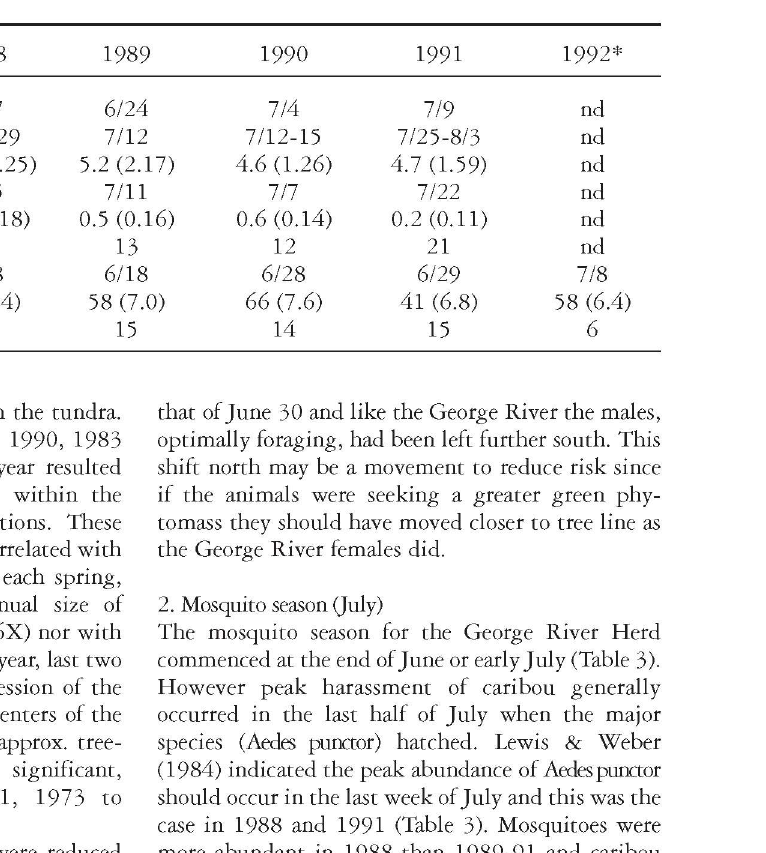
Table 3. Phenology dates (month/day) relative to summer energy budgets (1988-92). (Standard error of the mean in